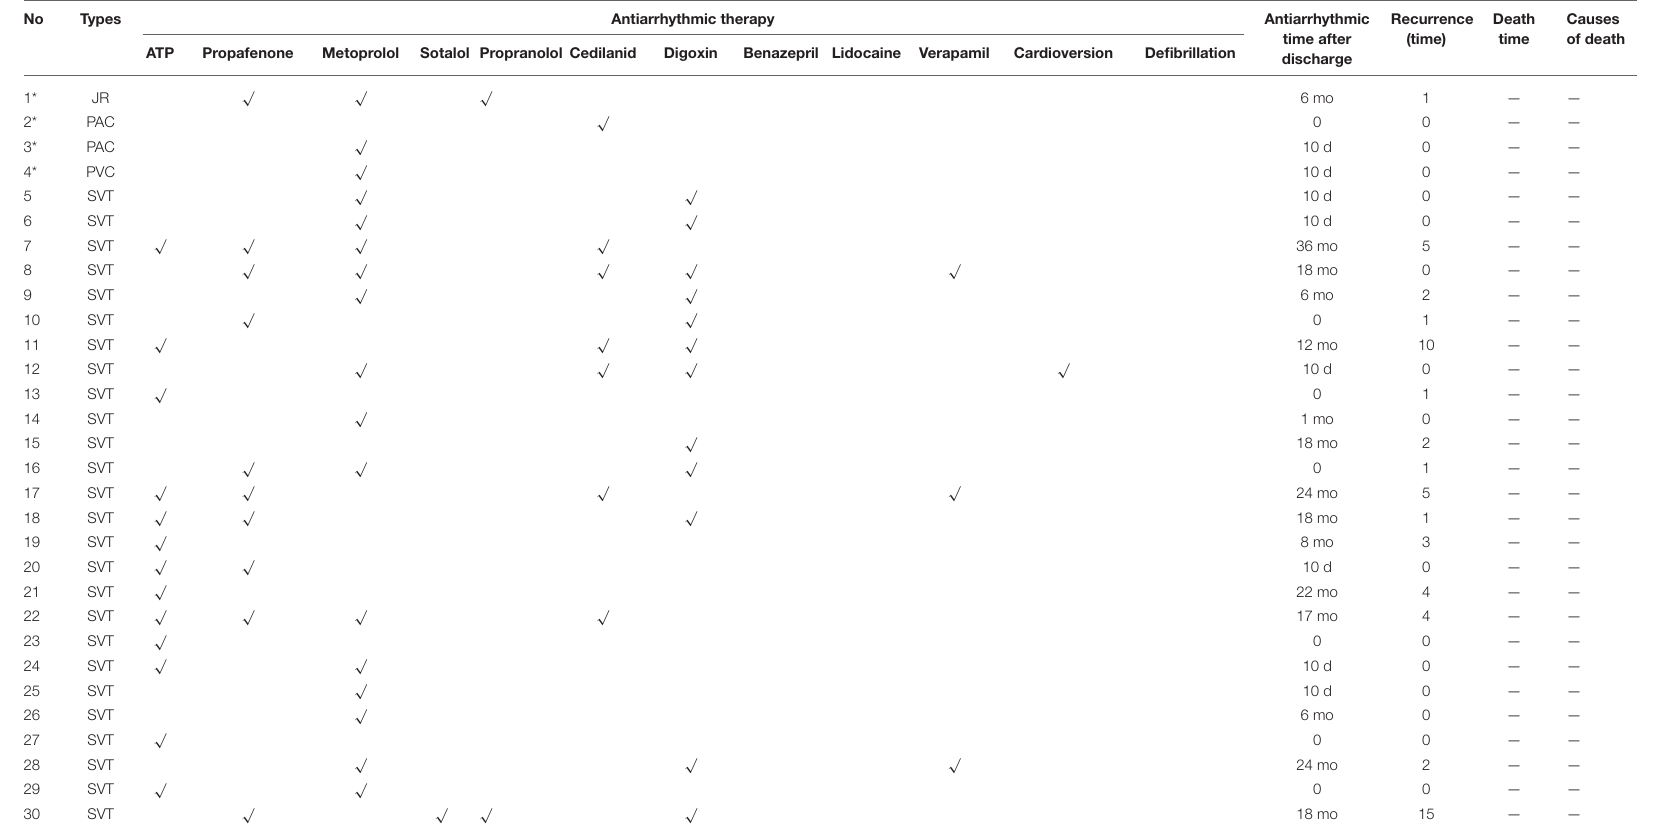
TABLE 3 | Antiarrhythmic therapy and